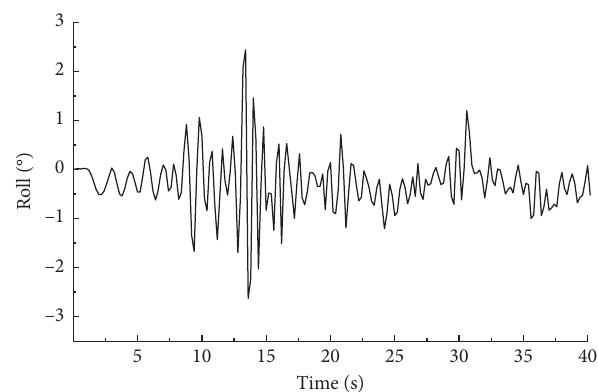
Figure 9: Time series of ship roll motion when moored at position II with bow and stern mooring.